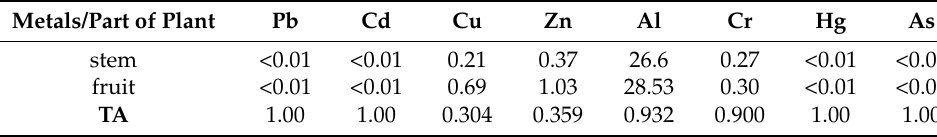
Table 8. Translocation ability, water chestnut,